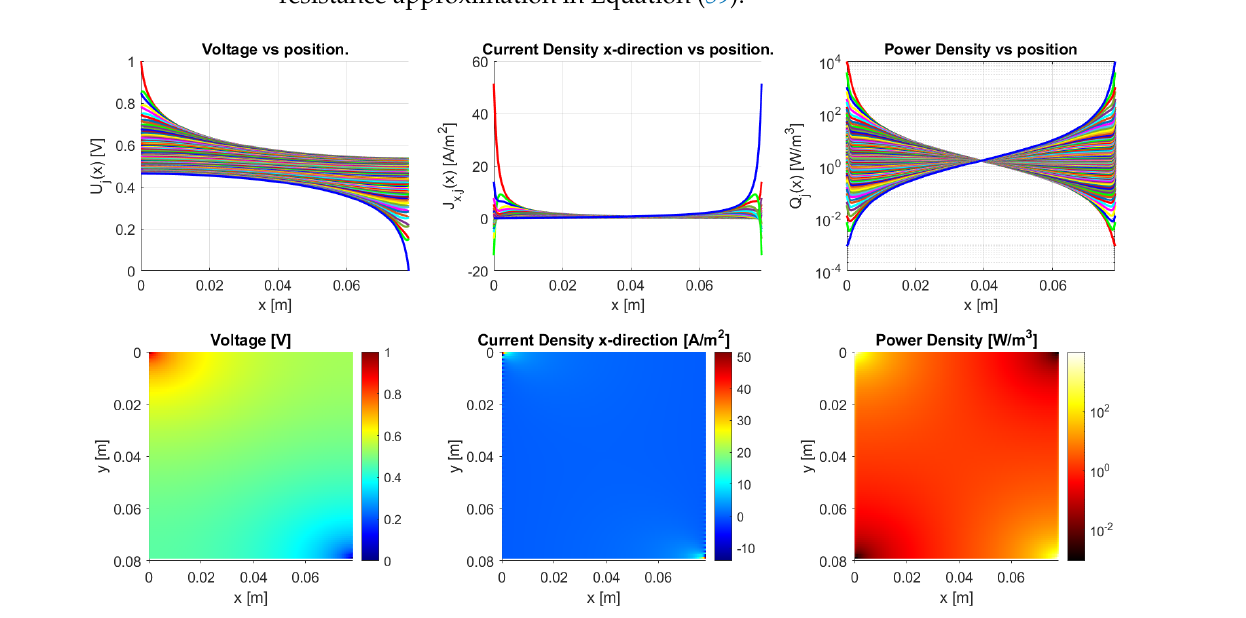
Figure 25. The model converges to a solution of the Laplacian for homogeneous anisotropic materials in the case of large numbers of traxels, in this case 99